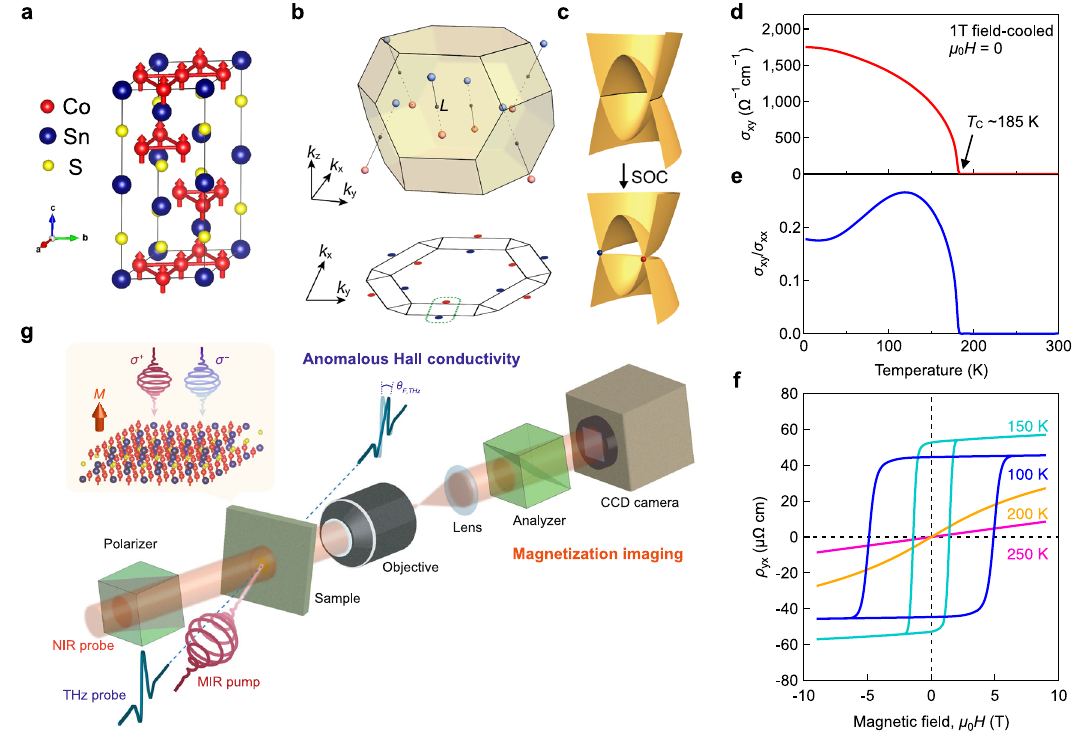
Fig. 1 Characteristics of the Co 3 Sn 2 S 2 thin fi lm. a , Unit cell of Co 3 Sn 2 S 2 where the cobalt atoms form a ferromagnetic kagome lattice. The magnetic moments are indicated by arrows along the c -axis. b Distribution of the Weyl points in the 3D Brillouin zone and the 2D momentum space projected in (001) direction. Red and blue represent the chirality (plus or minus) of each Weyl point. L points at the zone edge are indicated by black spheres. c Schematic band structure of Co 3 Sn 2 S 2 in ferromagnetic phase including the nodal ring (black line) for that without spin-orbit coupling (SOC) and the Weyl points (red and blue spheres) for that with SOC. d Anomalous Hall conductivity and e that divided by longitudinal conductivity as a function of temperature. The Curie temperature, T C , is indicated by the arrow. f Anomalous Hall resistivity versus magnetic fi eld curves at various temperatures. g Schematic of the terahertz (THz) Faraday rotation spectroscopy ( θ F ; THz : the Faraday rotation angle) and near-infrared (NIR) Faraday microscope system with left-hand ( σ (cid:1) ) and right-hand ( σ þ ) circularly polarized MIR pump pulse. The mid-infrared (MIR) pump is incident normally to the sample, that is, parallel to the c -axis along which the magnetization ( M ) is